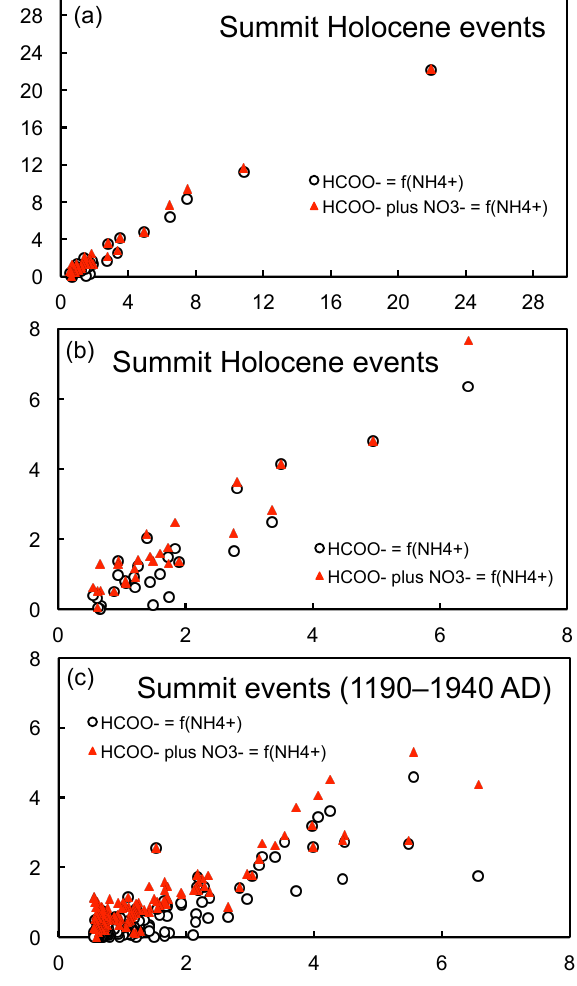
Figure 7. Ammonium vs. formate (formate plus nitrate) along NH + events at Summit. All concentrations are expressed in 4 µEqL − 1